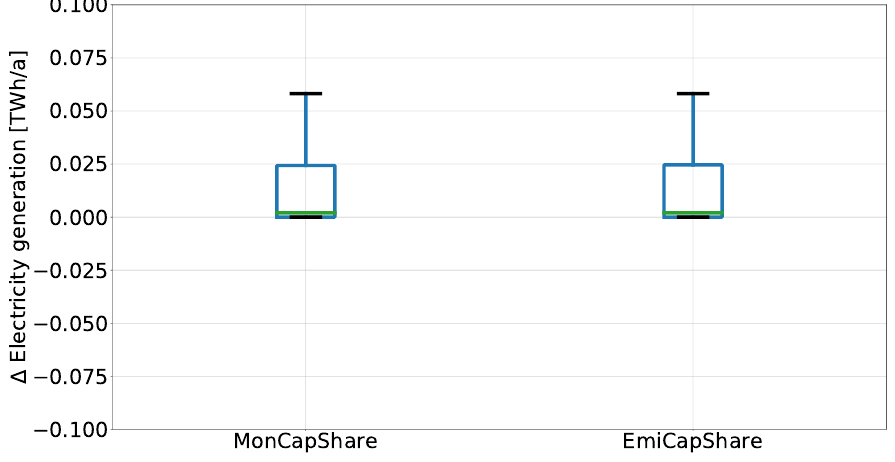
Figure A2. Deviation between CapShare scenarios and real world data for the generated electricity.